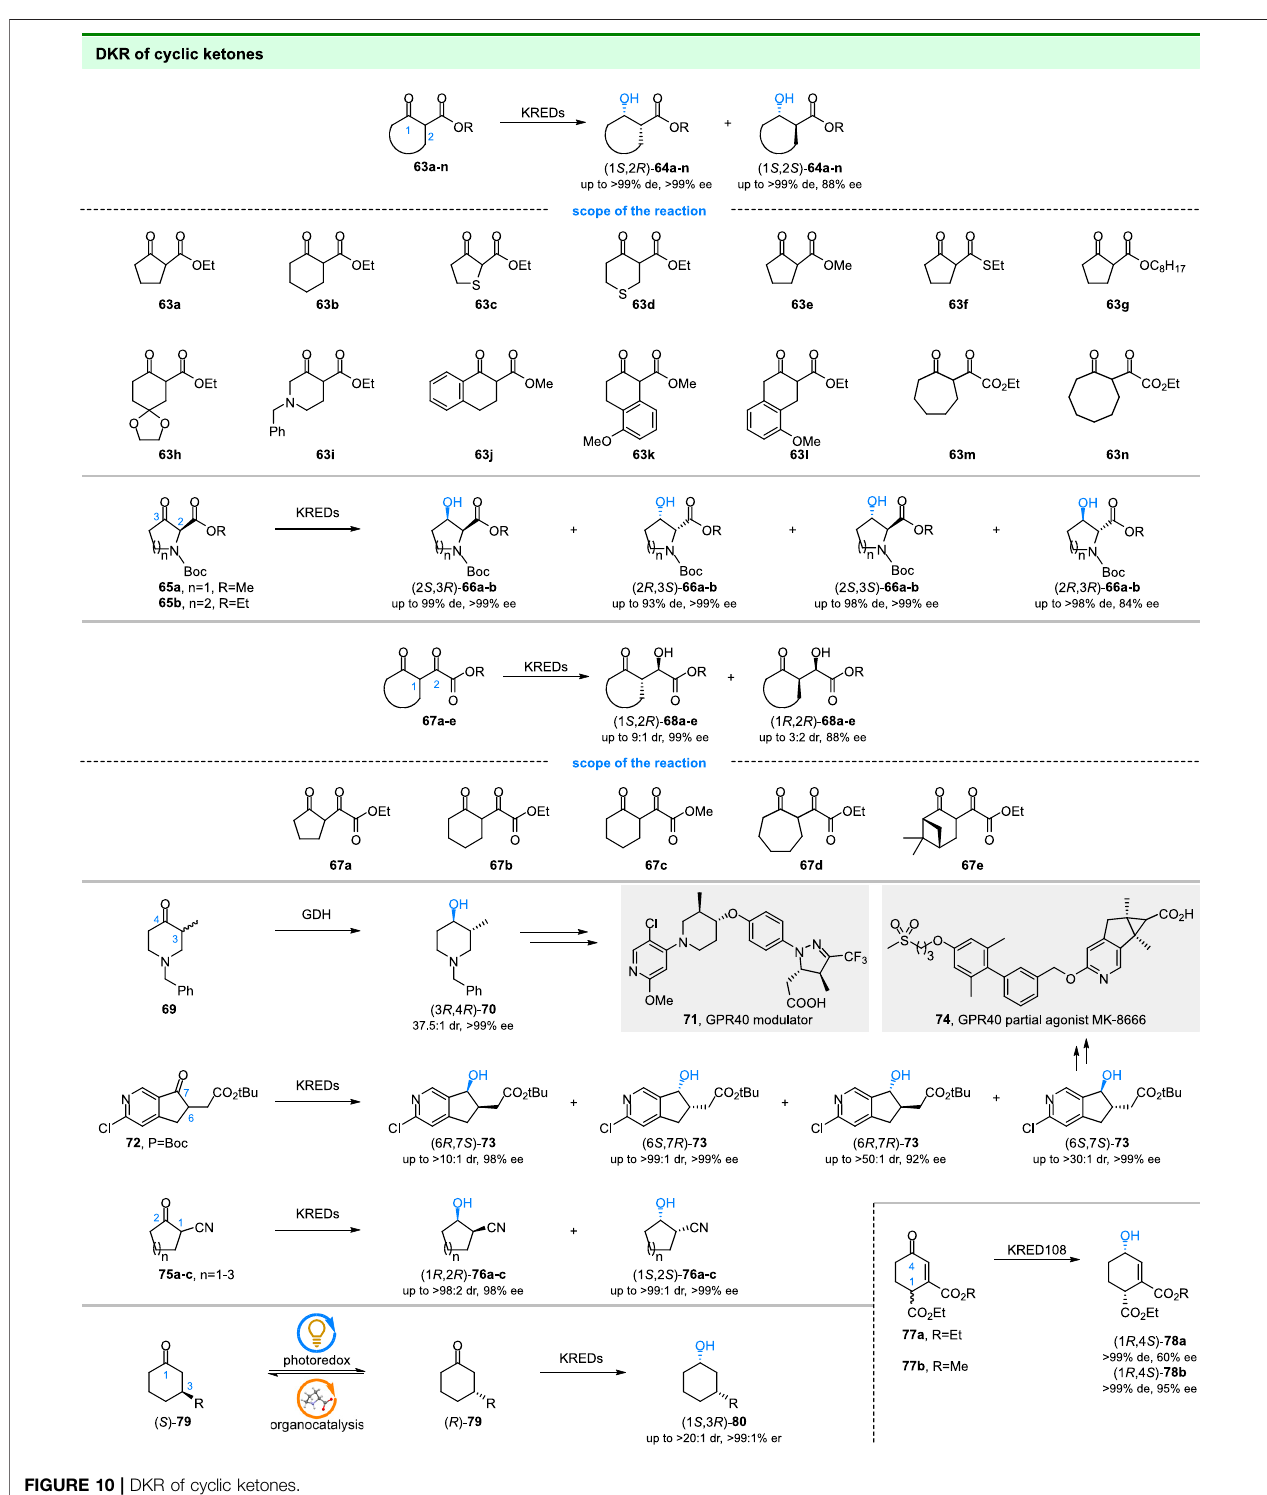
FIGURE 10 | DKR of cyclic